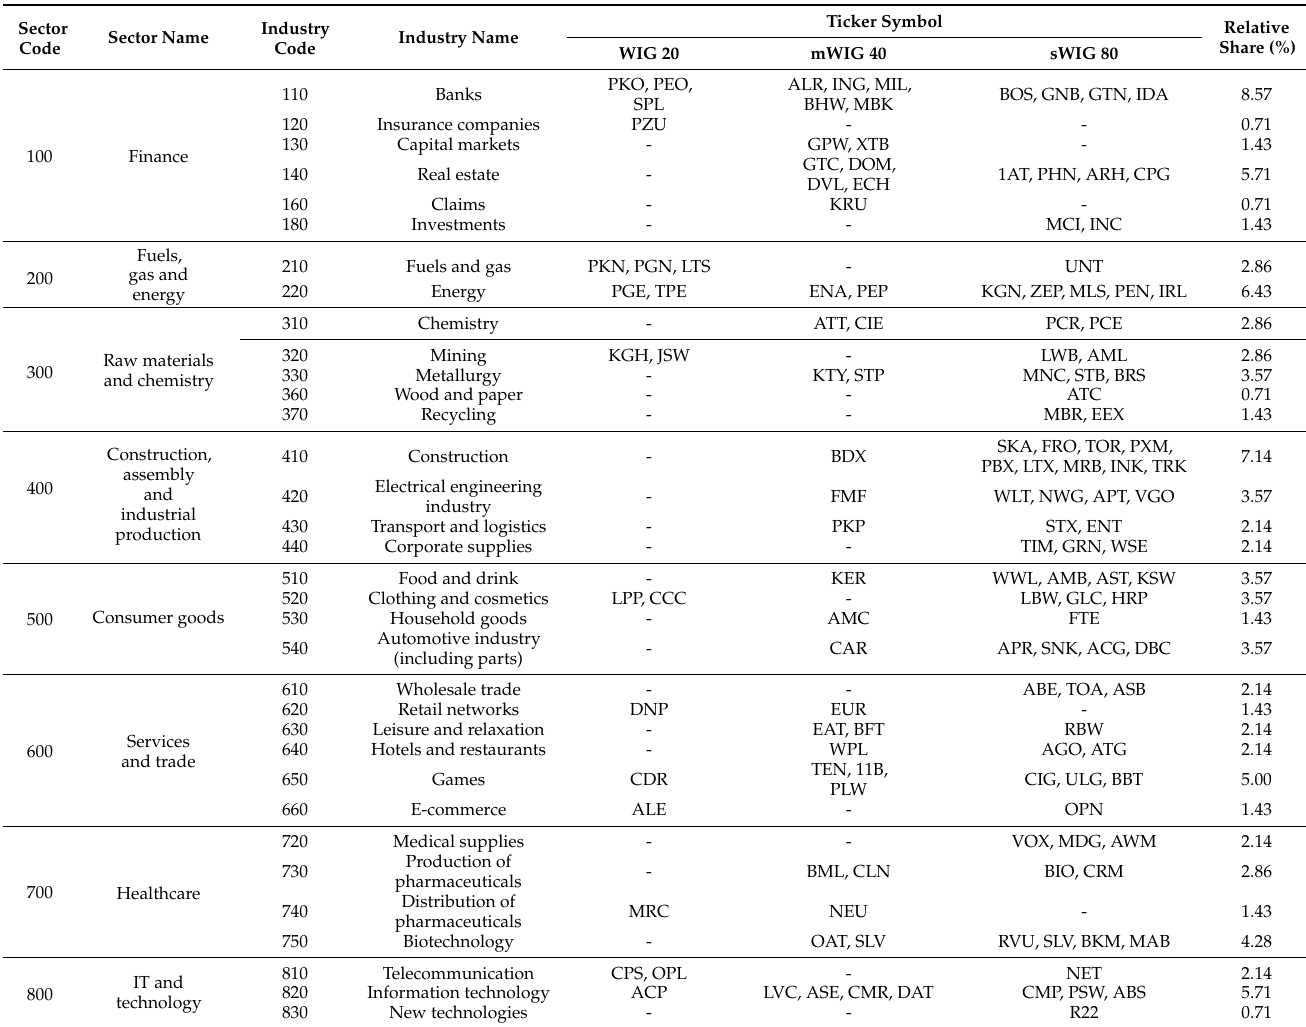
Table 1. Sectors and industries represented by the analysed companies from WIG20, mWIG 40, and